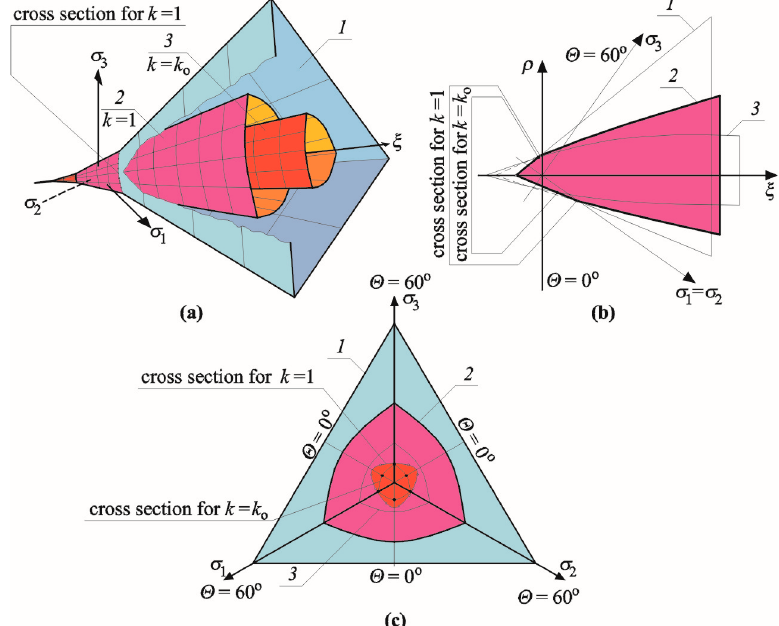
Figure 9. The relative position of the Rankine and M-W-3 surfaces at λ t = 2: ( a ) view of surfaces in principal stress space, ( b ) axiatoric sections, ( c ) deviatoric sections; 1 —Rankine surface, 2 —M-W-3 surface at k = 1 (yield strength), 3 —M-W-3 surface at k = k o (end of elastic stage). The required material parameters were obtained from the laboratory tests and validation of the Table 4. Parameters of the plastic and elastic model used in calculations. model described in the paper [42]. Table 4 presents material parameters for the wall and lintels used in numerical